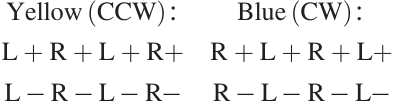
FIG. 25. Field along RHIC closed orbit across a 360°-twist rotator helix. Top: outer “ L þ ” left-handed helix ( k < 0 , B 0 > 0 ). Bottom: inner “ R þ ” right-handed helix ( k > 0 , B 0 > 0